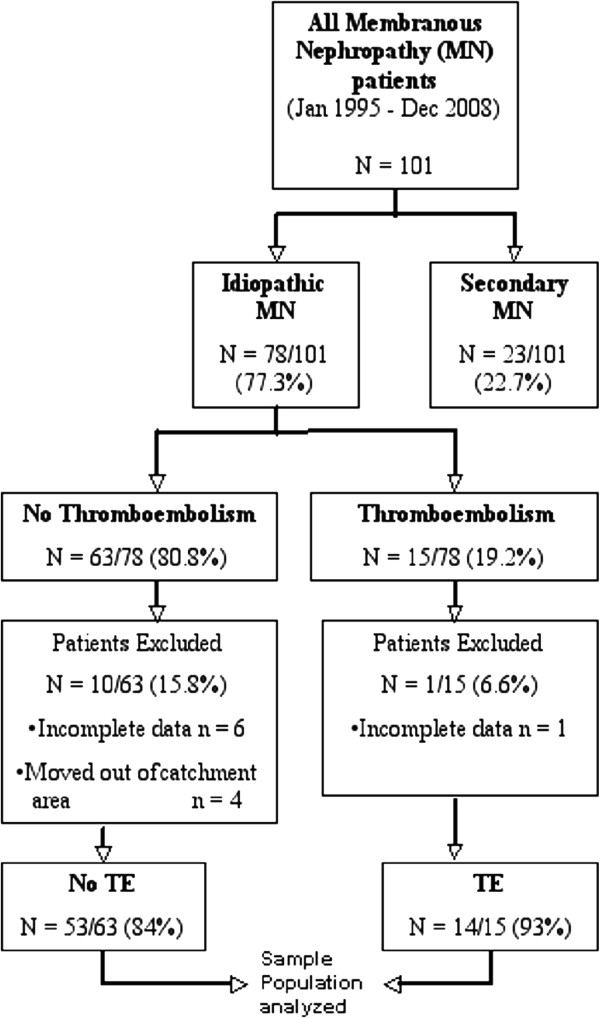
Flow diagram showing all consecutive biopsy-proven membranous nephropathy patients diagnosed at our centre between January 1995 and December 2008.